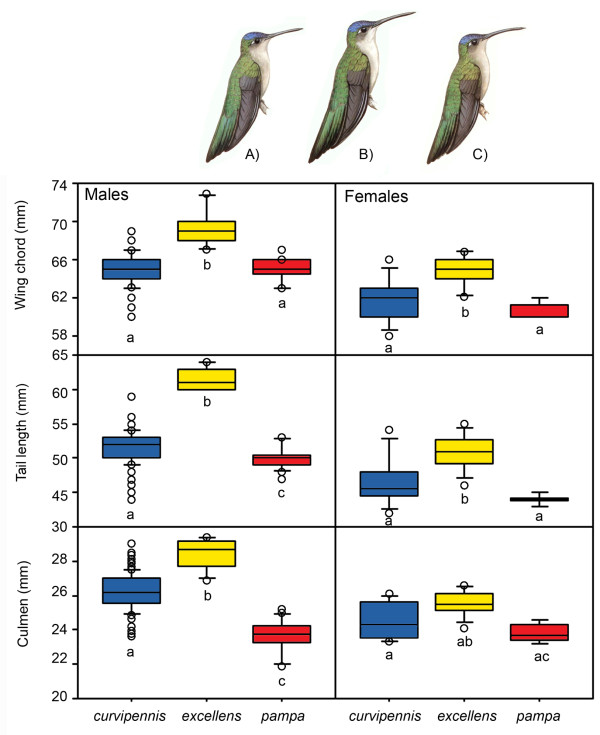
Morphological traits taken for males and females of C. curvipennis lineages. Boxplots show the 10th, 25th, 50th (median), 75th, and 90th percentiles. Values above the 90th and below the 10th percentile are plotted as open circles. Illustrations correspond to C. c. curvipennis (A), C. c. excellens (B) and C. c. pampa (C) taken from the Handbook of the Birds of the World [32].